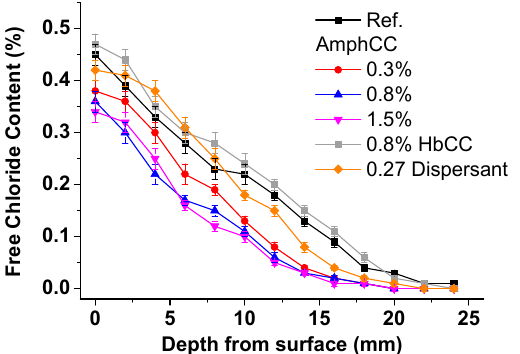
Figure 6. Free chloride content distribution from the surface of samples with the AmphCC addition after 56 d chloride treatment.